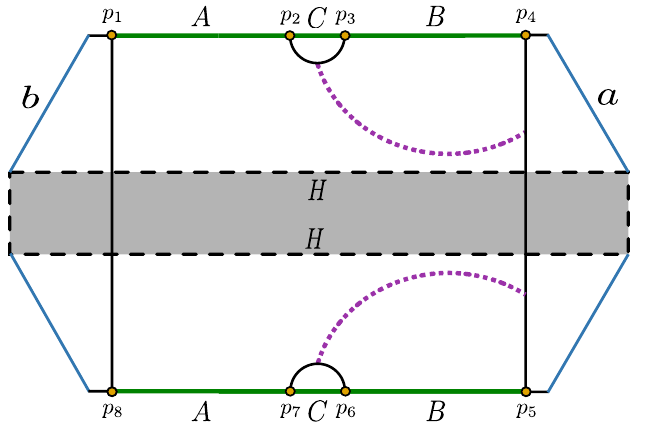
Figure 31 . The endpoints of the intervals A and B in the two BCFT 2 copies are identified similarly as in figure 20.